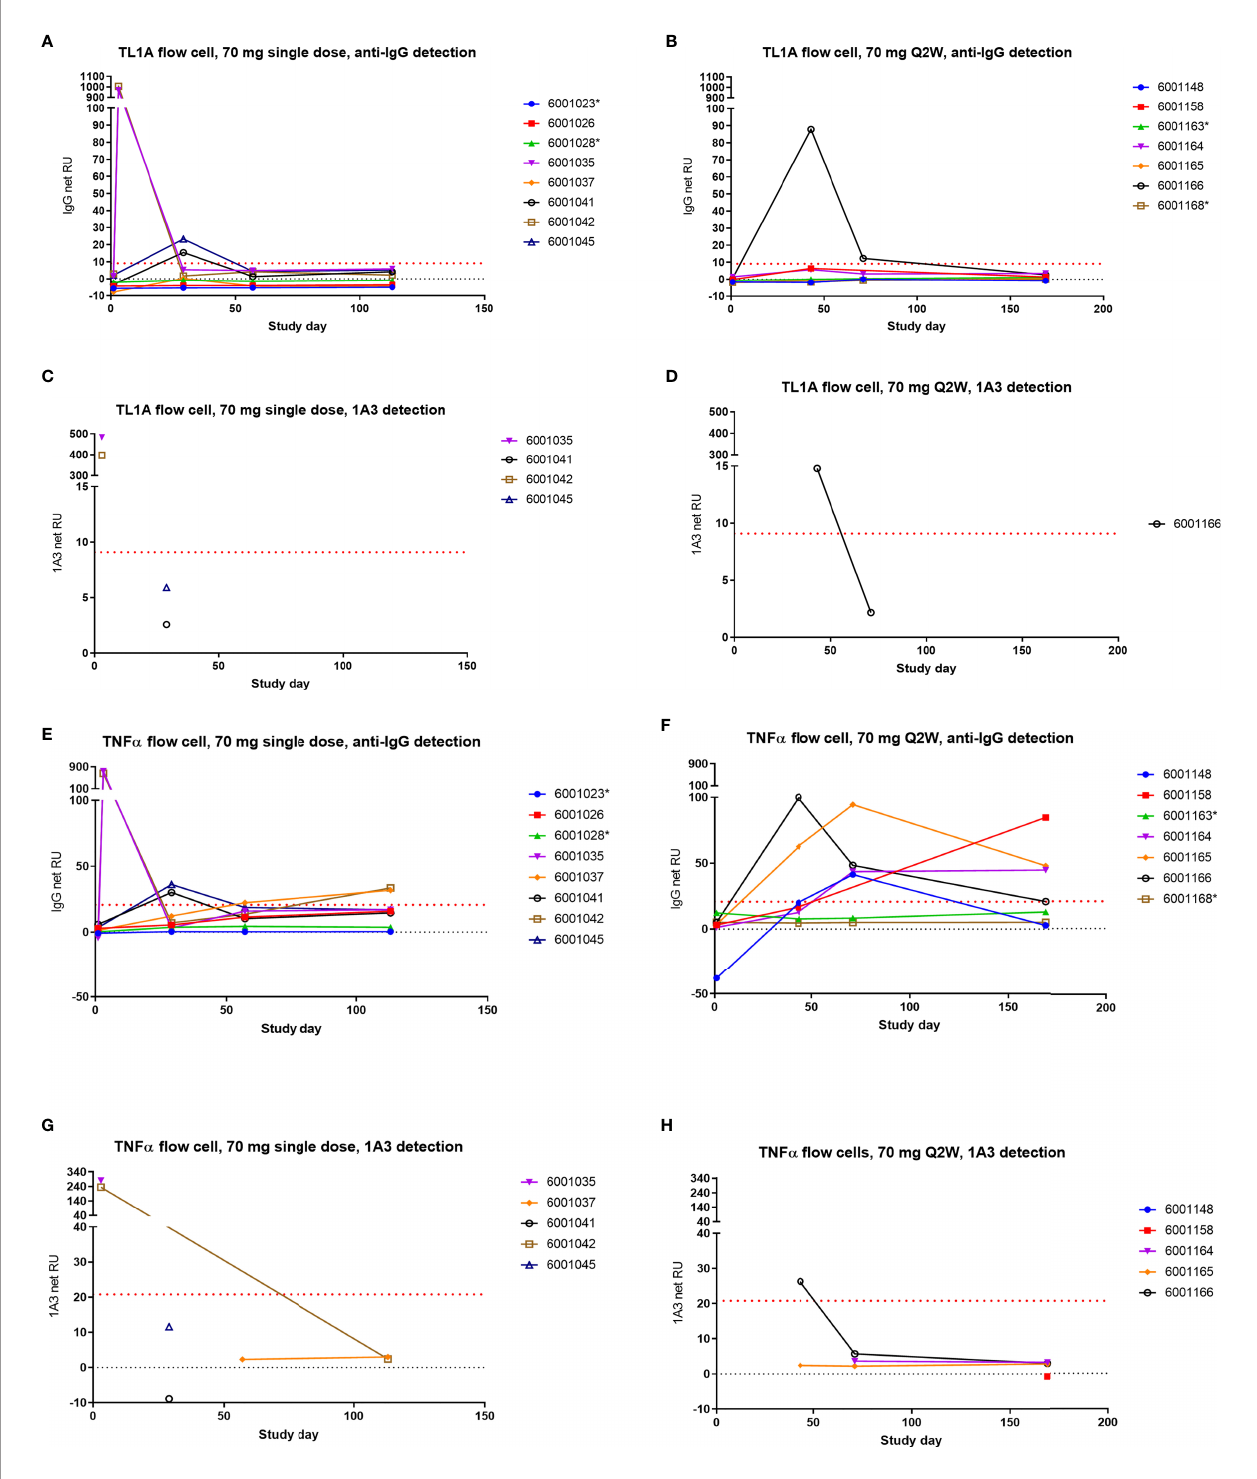
FIGURE 8 | AMG 966 elicited endogenous antibodies to TNF a but not TL1A. Subjects from cohorts 2 and 7 were tested for endogenous antibodies to TNF a and TL1A using an SPR approach. One AMG 966-treated subject from cohort 7 who withdrew from the study early was not included. Samples with reactivity for TL1A or TNF a based on anti-human IgG detection were further tested using the AMG 966-speci fi c 1A3 reagent for detection. Asterisks indicate subjects in the placebo group. Cohort 2 (A) and cohort 7 (B) were assessed for TL1A binding antibodies and reactive samples were further tested for 1A3 binding (C, D) . Cohort 2 (E) and cohort 7 (F) were also tested for TNF a binding antibodies and reactive samples were further tested for 1A3 binding (G, H)